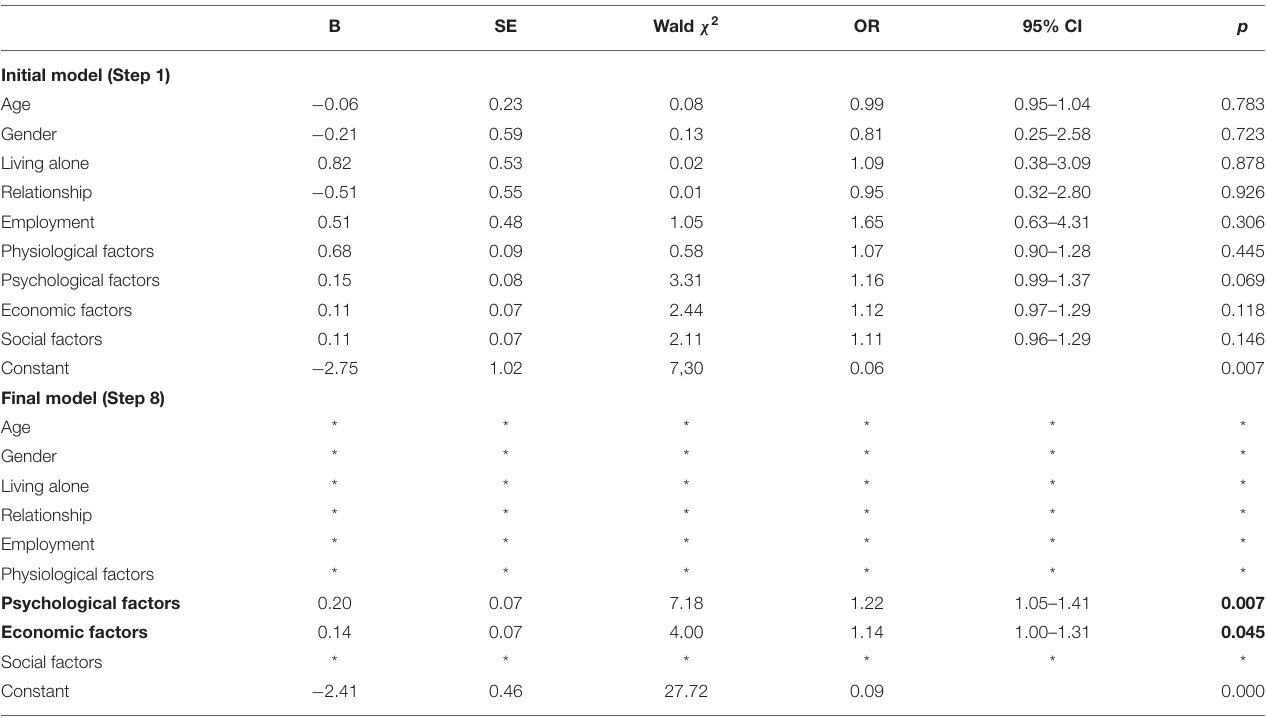
TABLE 2 | Results of the binary logistic regression model for patients with high (vs. low) risk of COVID-19 related PTSD symptoms (according to a cutoff score of 24 in the IES-R). B SE Wald χ